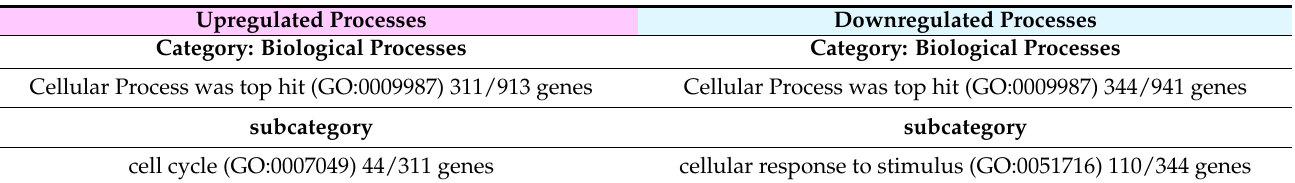
Table 3. Representative enriched pathways, ontologies, and transcription factors filtered by PAN- THER (from November 2019).